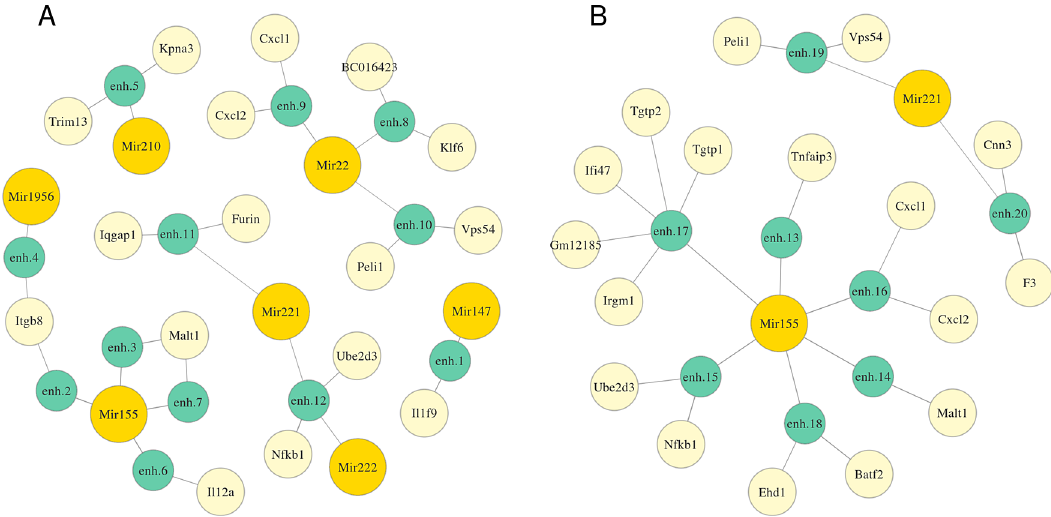
Figure 2. Predicted regulation graphs of miRNAs via RNA:DNA duplex (A) or RNA:DNA triplex formation (B) with an enhancer for M0 macrophages. The length of an edge between a miRNA and an enhancer or between anenhancerandageneisininverseproportiontotheaveragecorrelationbetweentheexpressionofthemiRNAand the target gene or the enhancer and the gene respectively. Full coordinates of enhancers are available in Table S1.